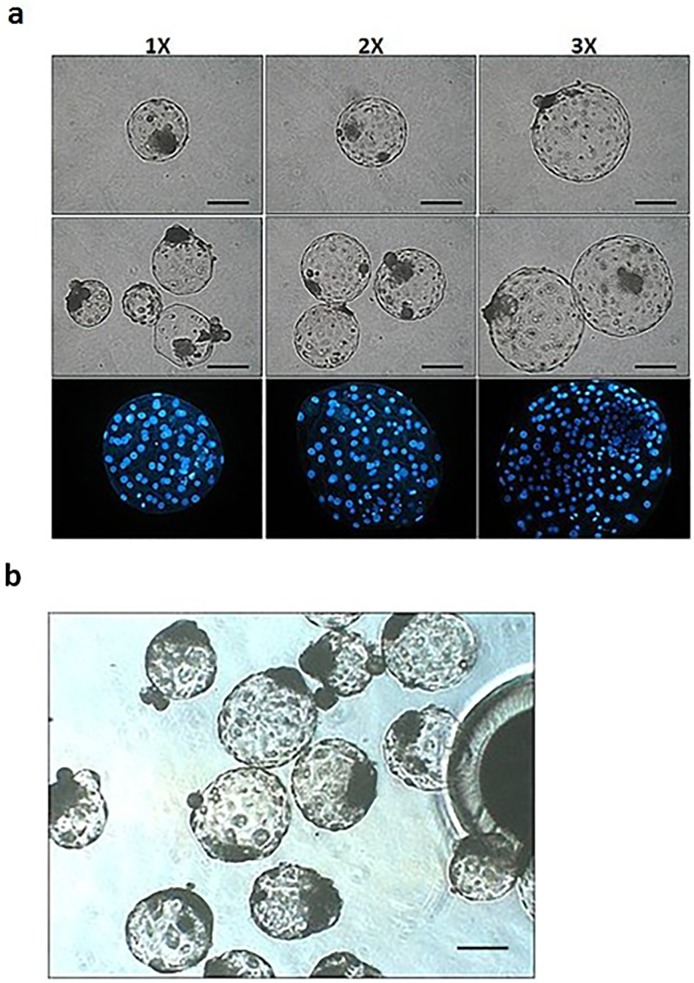
Morphologies of aggregated cloned and PA blastocyst embryos.(a) Day-7 cloned porcine blastocysts produced by OBCT and embryo aggregation. 1×: single cloned embryo; 2×: two cloned embryos were aggregated in a well, and 3×: three cloned embryos were aggregated in a well. (b) Day-7 3× aggregated porcine parthenogenetic embryos. Scale bar = 100 μm.